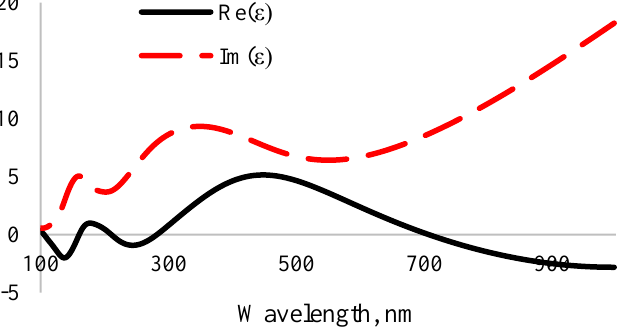
Figure 6. Dependence of the complex permittivity of MoO 3 on light wavelength. After calculating the real and imaginary parts of the complex permittivity, the real and imaginary parts of the complex refractive index were determined by solving the system of equations given in Formula (15). Based on the obtained results, the dependence of the real and imaginary parts of the complex refractive index on the light wavelength is shown in Figure 7.